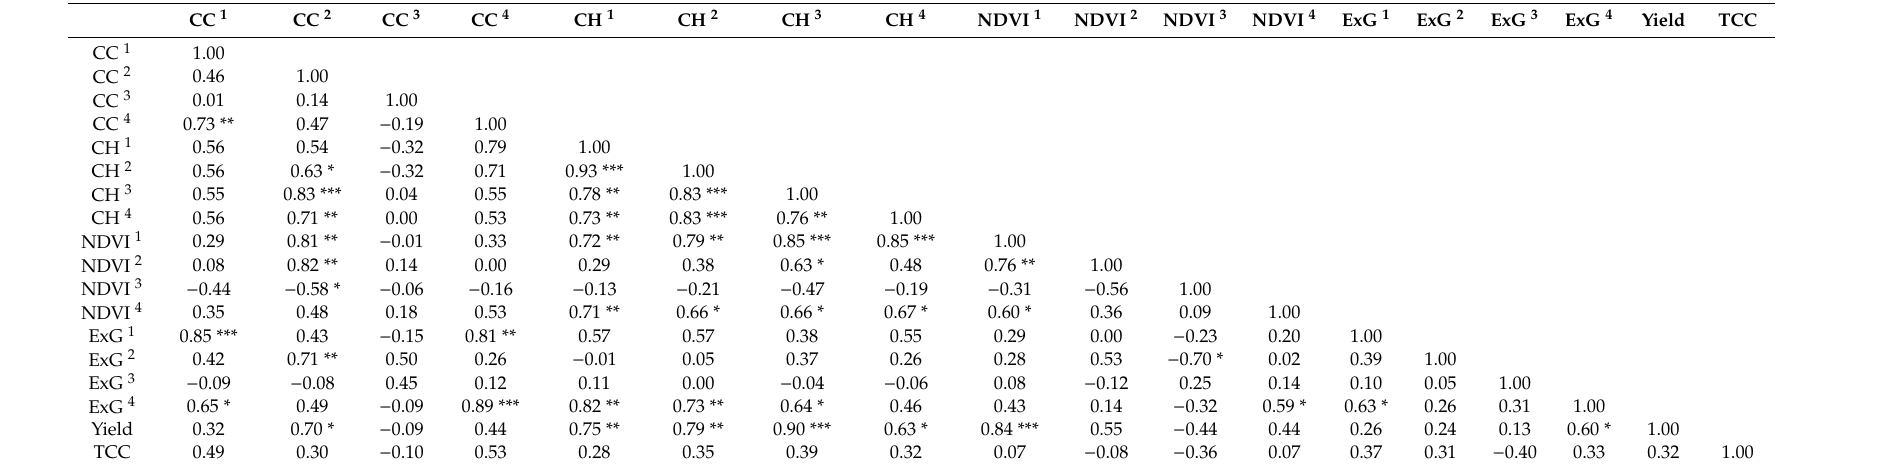
Table 3. Correlation coe ffi cient matrix between CC, CH, NDVI, ExG, yield, and